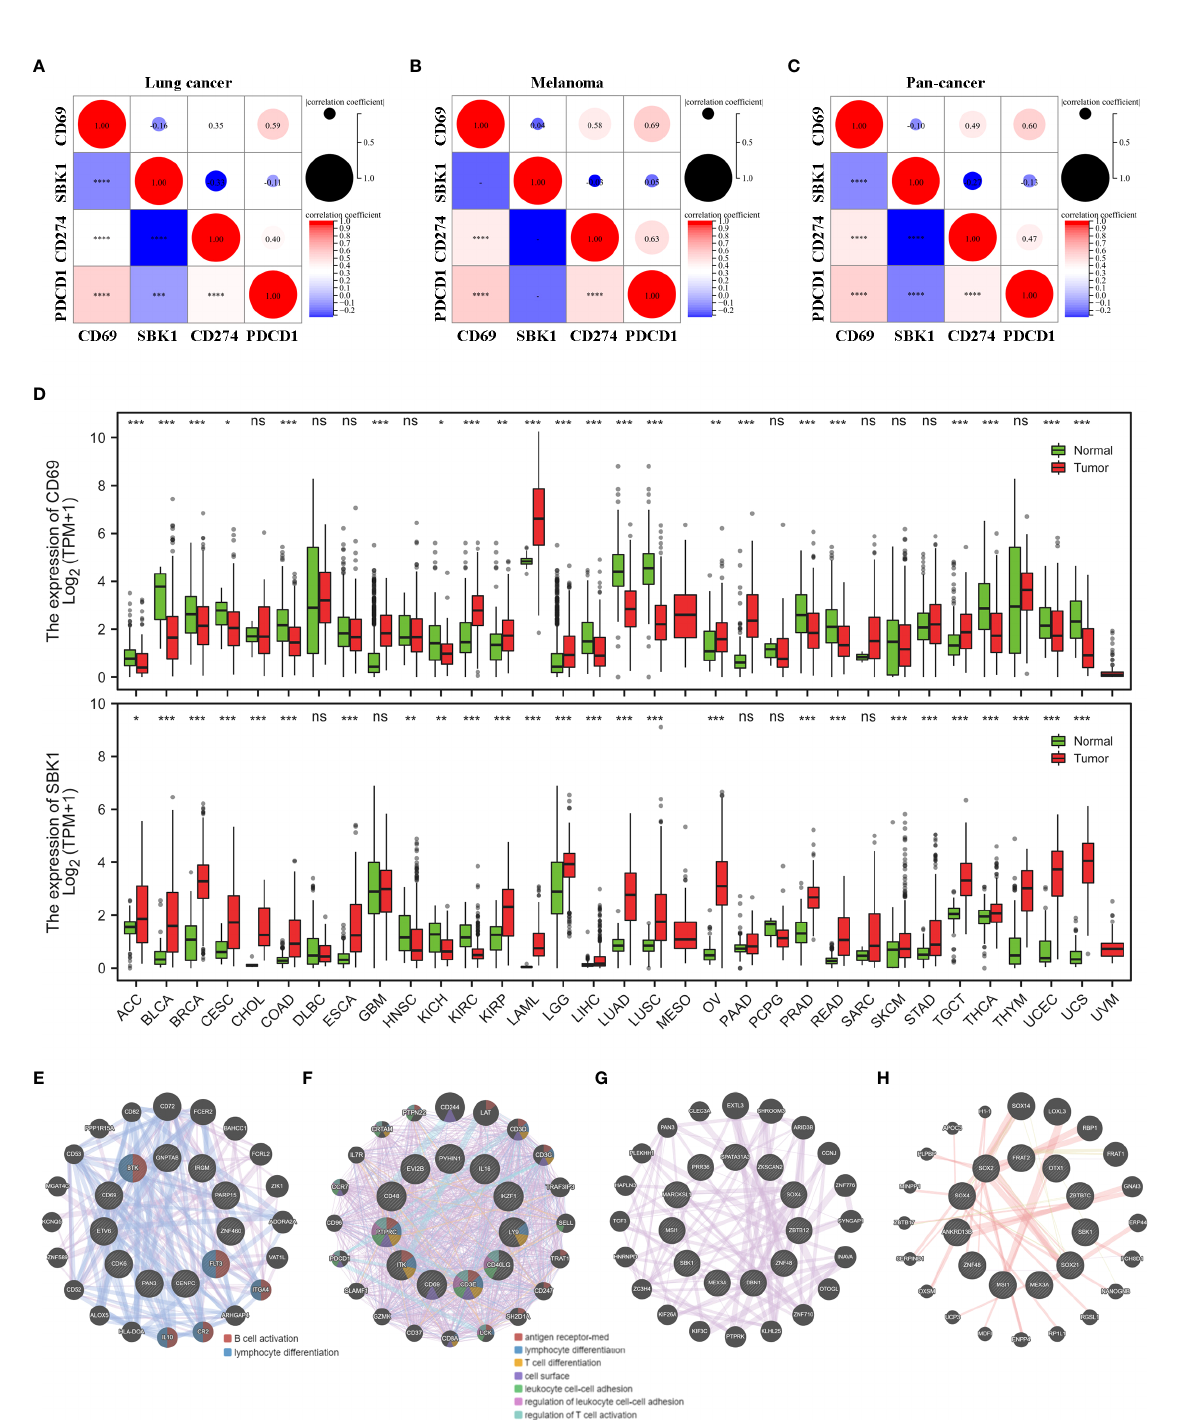
FIGURE 3 CD69 and SBK1 are aberrantly expressed in most TCGA tumors. (A, C) Separate analysis of correlation between CD69 , SBK1 , PD-L1 ( CD274 ), and PD-1 ( PDCD1 ) expression in TCGA lung cancer (A) , melanoma (B) , and pan-cancer (C) . (D) Differences in the expression of CD69 and SBK1 in TCGA tumors versus corresponding normal tissues. (E, F) PPI analysis of CD69 similar genes in its 8 upregulated (E) and 14 downregulated (F) tumors. (G, H) PPI analysis of SBK1 similar genes in its 23 upregulated (G) and 3 downregulated (G) tumors. – indicates not signi fi cant (ns). * indicates p<0.05. ** indicates p<0.01. *** indicates p<0.001. **** indicates